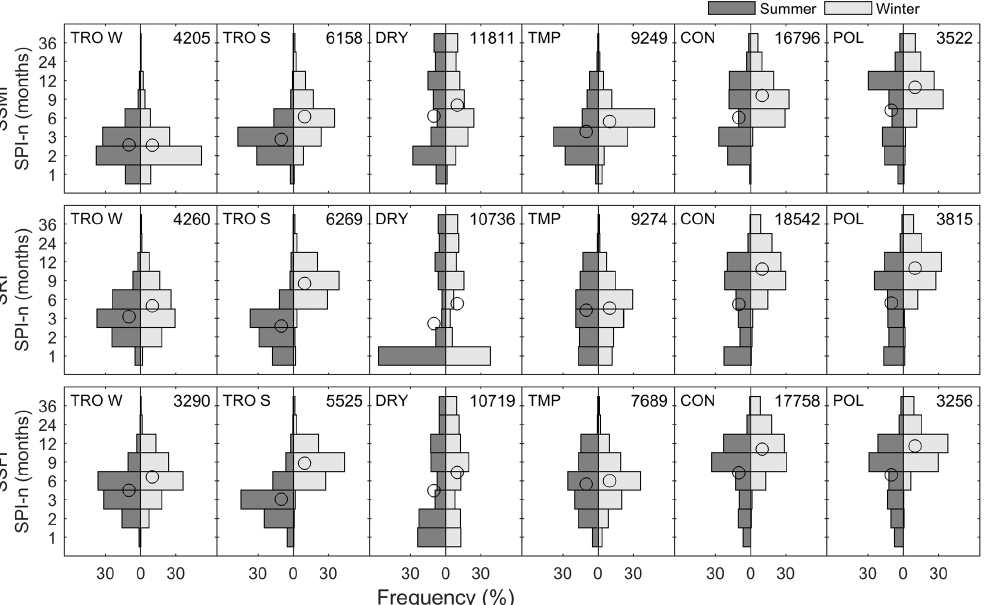
Figure 3. Histograms of the SPI-n in months by climate type and for summer and winter droughts in SSMI, SRI, and SSFI. Circles represent the mean rank SPI-n per climate type, and season and numbers in the upper right indicate the number of summer and winter data pairs per climate and drought type. Abbreviations of climate types are the same as in Fig.